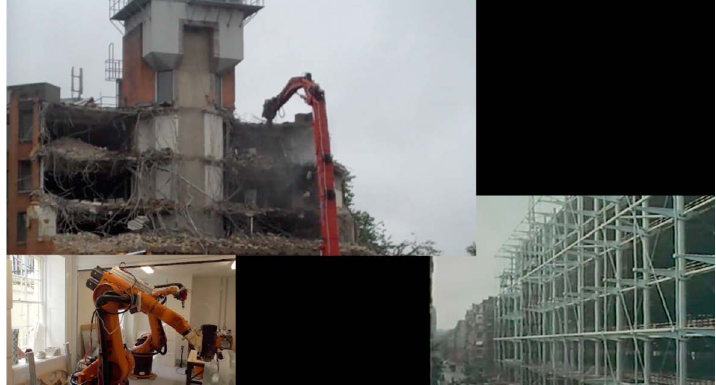
Stills from the short film, The Death and Life of UK Universities (Source: c (cid:13) Igea Troiani and Tonia Carless, 2020). The stills show documentary footage of the demolition of the Lloyd Building at Oxford Brookes University, which took place in summer 2010, and a robotic model building arm at the Architectural Association in London. The bottom right-hand still shows an excerpt from Conical Intersect by Gordon Matta-Clark